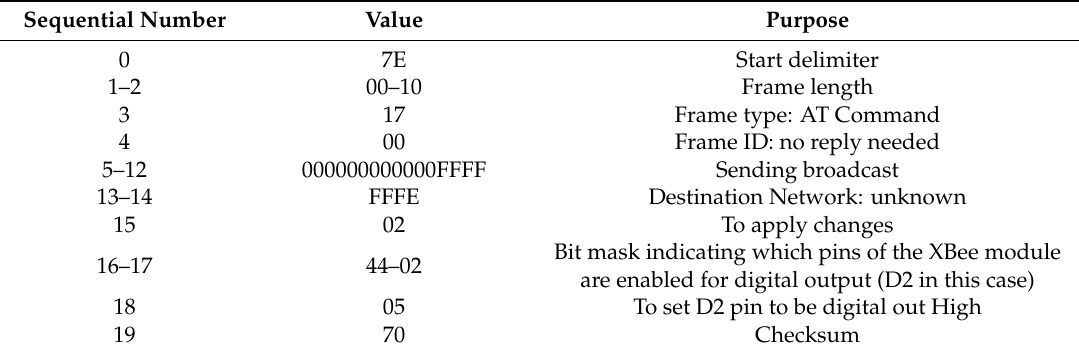
Table 2. Communication data frame structure.